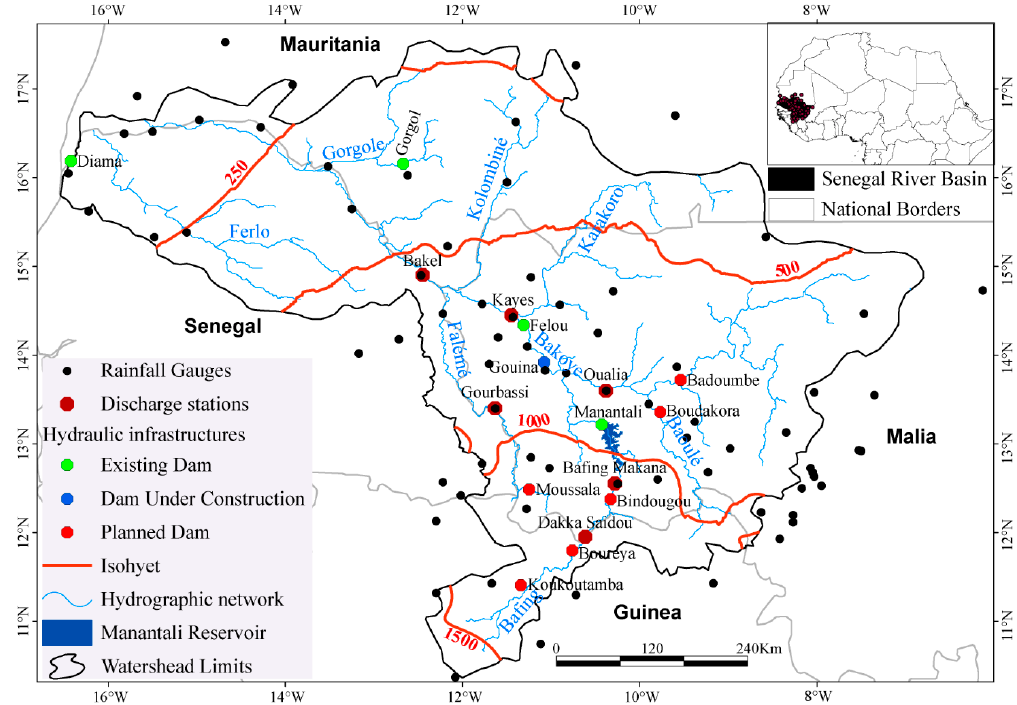
Figure 1. Senegal River Basin, hydrographic network, river flow stations, rainfall gauges, and main hydraulic infrastructures.